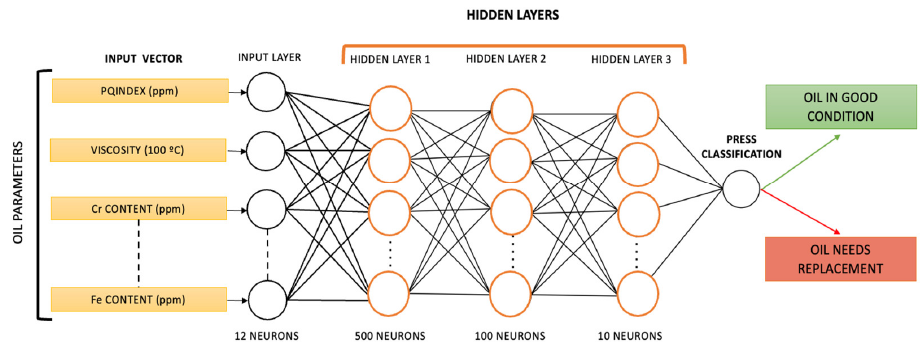
Figure 13. Architecture ANN for classification for oil.